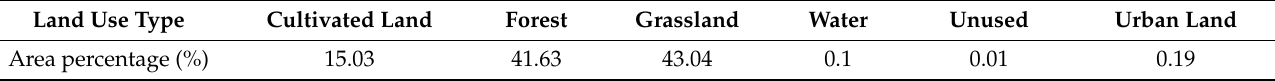
Table 4. Area percentages of land